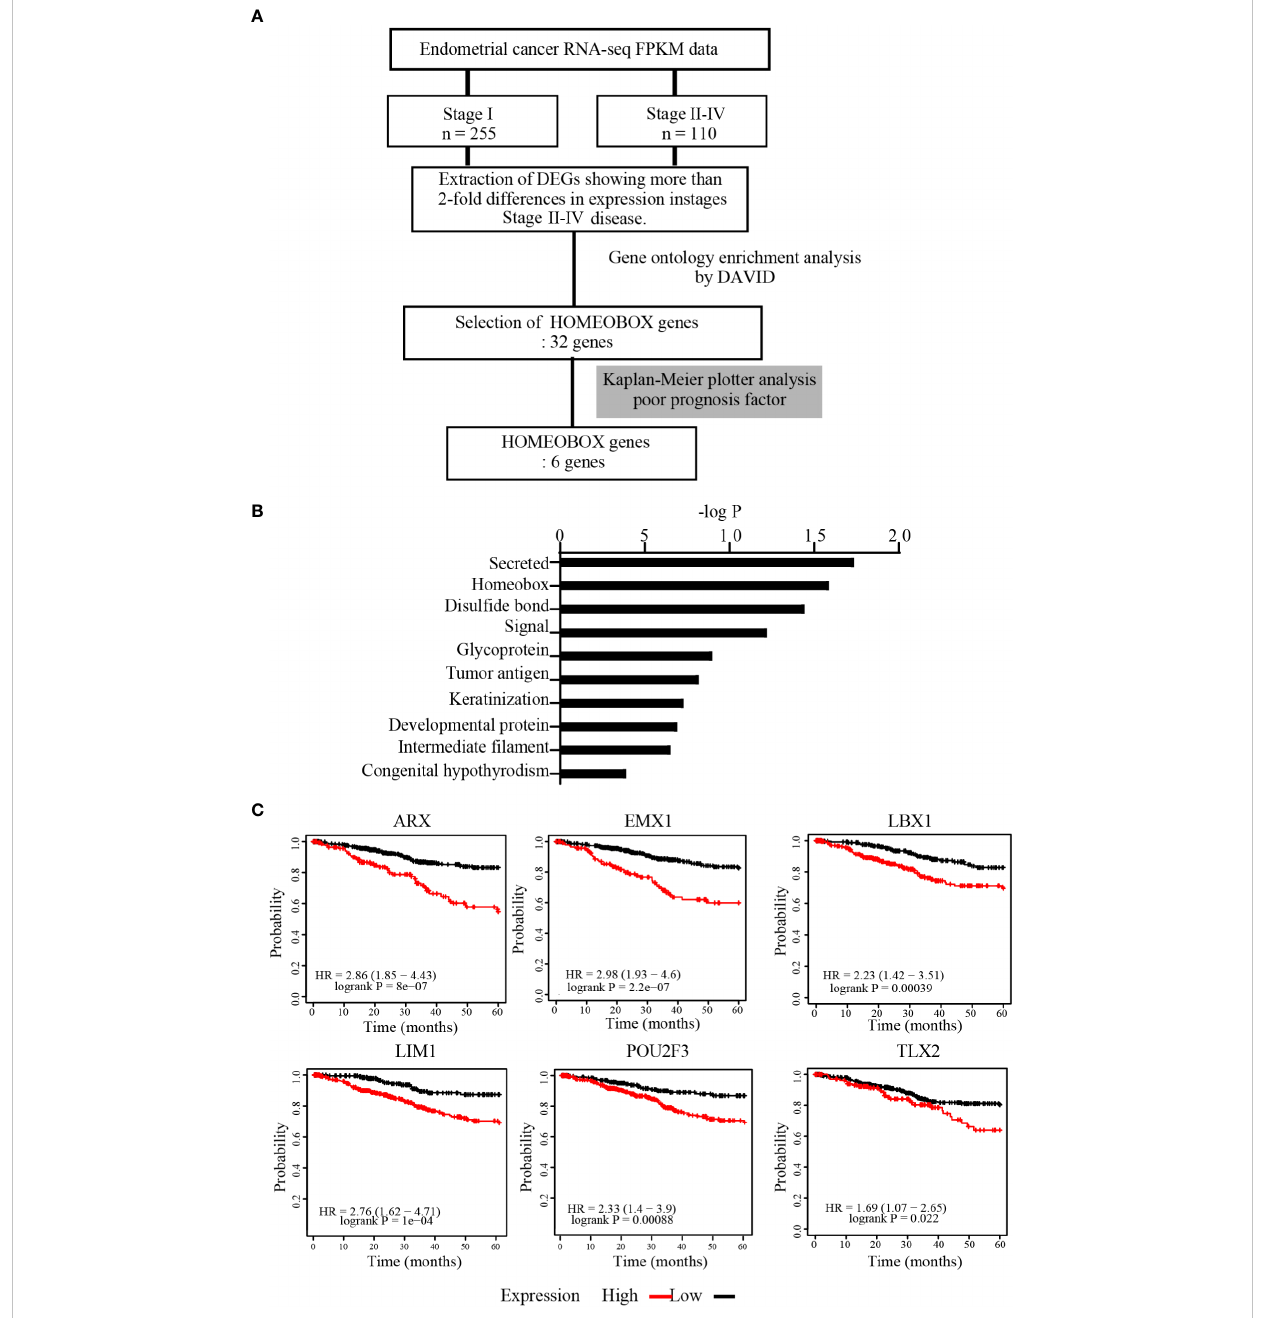
FIGURE 1 HOMEOBOX genes were enriched in upregulated genes in advanced EC. (A) Strategy for identi fi cation of upregulated genes from datasets registered in TCGA. (B) Gene Ontology (GO) enrichment analysis of genes extracted from TCGA that were upregulated more than 2-fold in stages II – IV EC compared with stage I EC by DAVID Bioinformatics Resources. (C) Analysis of the 5-year overall survival rate by Kaplan-Meier plotter for 6 genes within the HOMEOBOX gene